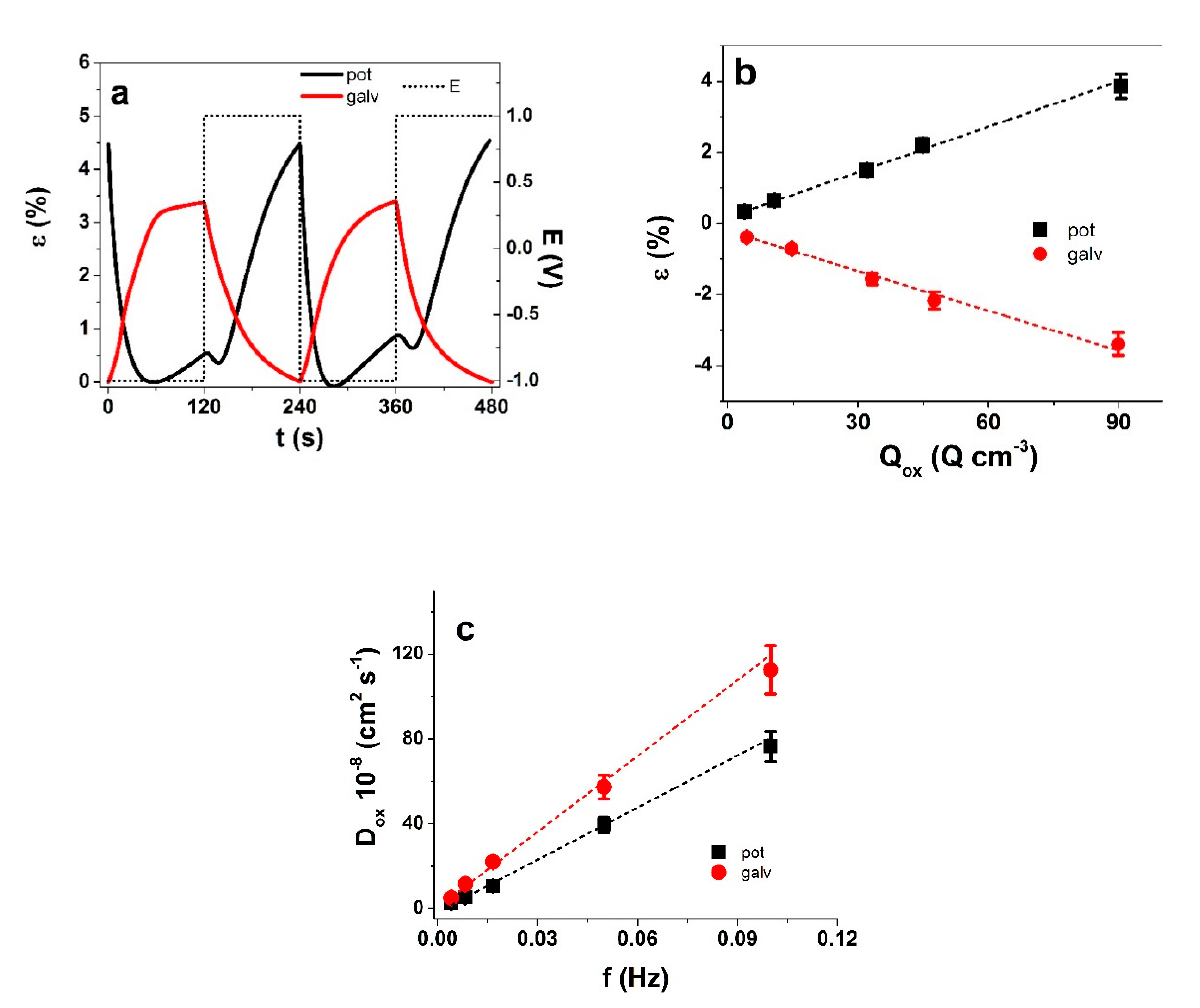
Figure 7. Response to square wave potential steps in TBACF 3 SO 3 PC of PPy(pot) (black) and PPy(galv) (red) ( a ) strain vs. time (2 subsequent cycles 3rd–4th) at ± 1 V (dotted) and 4.17 mHz. ( b ) strain vs. charge density Q ox on oxidation; ( c ) diffusion coefficients upon oxidation D ox obtained from Equations (1) and (2) vs. frequency f. The dashed lines in ( b , c ) represent linear fits and are shown here only for orientation. Negative values of strain in b represent opposite actuation direction.